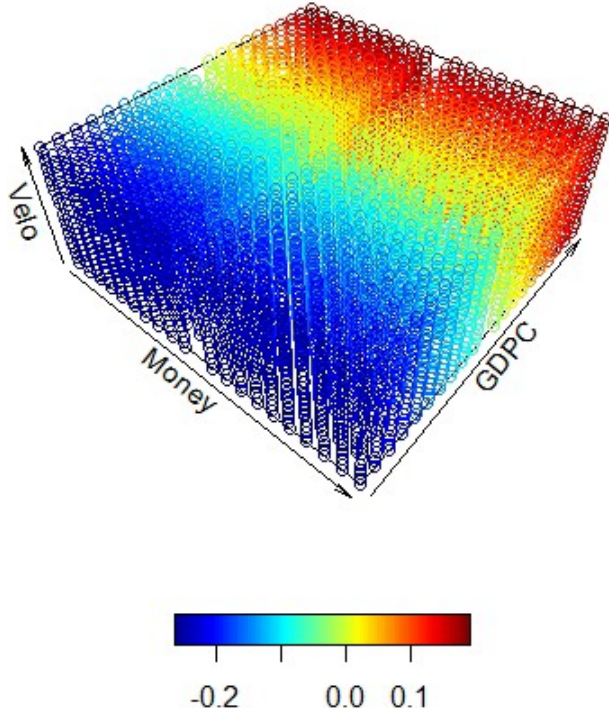
Figure 3. Historic data plot of quantity of money, velocity of money, GDP, and GDP deflator from 1 January 1960 to 1 July 2021. The color scale represents the change of the GDP deflator, with respect to inflation, in response to changes in the quantity of money, the velocity of money, and GDP (GDCP1). J. Risk Financial Manag. 2022 , 15 , x FOR PEER REVIEW